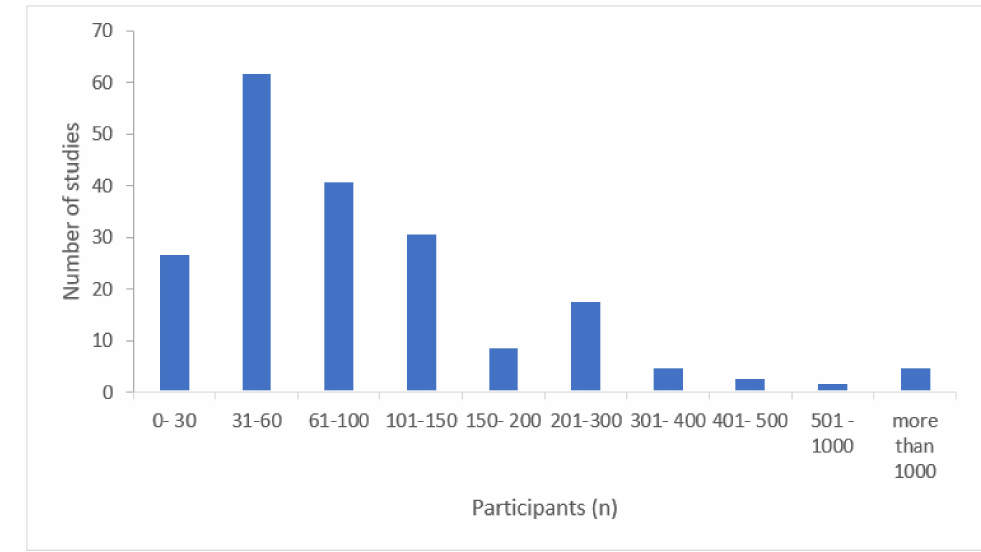
Figure 3. Number of studies according to the sample